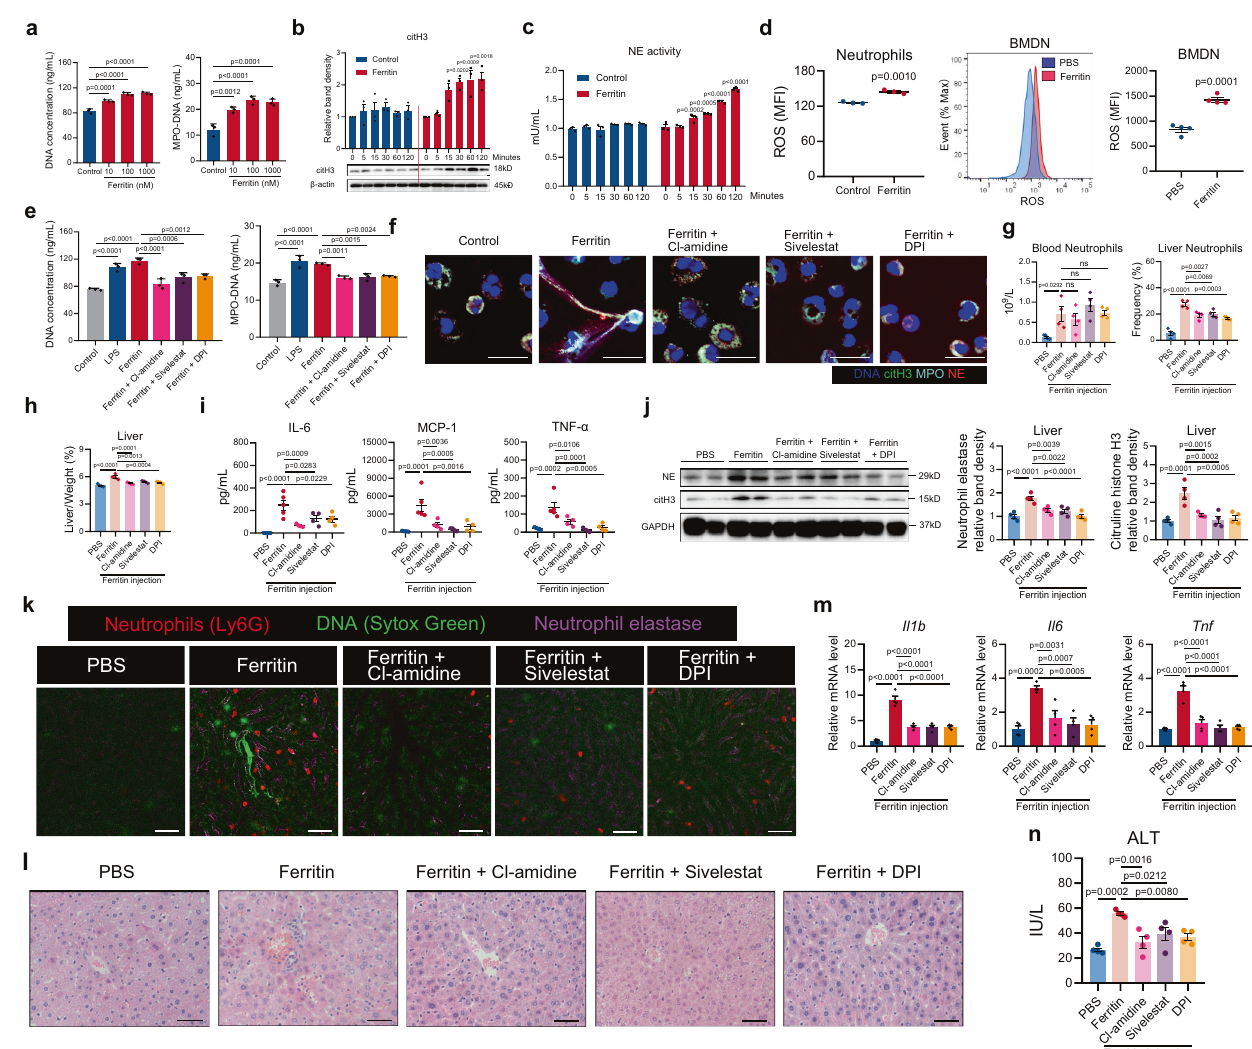
Fig. 4 | Ferritin-induced NETosis is dependent on PAD4, NE and ROS. a Quanti fi cationofcell-freeDNAandMPO-DNAcomplexesreleasedbyneutrophils from healthy donors stimulated with 10, 100 and 1000nM ferritin. Plots show means±SD from one representative experiment with n =3 technical replicates. Resultswerecon fi rmedintenindependentexperimentsforcell-freeDNAandthree independent experiments for MPO-DNA using cells from different donors. b , c Changes of citH3 levels ( b ) and NE activity ( c ) in healthy donors ’ neutrophils upon ferritin stimulation ( n =3 biologically independent experiments). Repre- sentative Western blotting of citH3 was shown. d Detection of ROS by fl ow cyto- metry in ferritin-stimulated human neutrophils (representative results from three independent experiments) and BMDNs from ferritin-treated mice ( n =4). e , f The inhibitory effects of PAD4, NE and ROS with corresponding inhibitors Cl-amidine, sivelestat and DPI on ferritin-induced NET formation were detected by cell-free DNA, MPO-DNA complexes ( e ) and immuno fl uorescence of MPO (cyan), NE (red), citH3 (green) and DNA (blue) ( f ) in neutrophils from healthy donors. Scale bars, 20 μ m.Plotsin( e )showmeans±SDfromonerepresentativeexperimentwith n =3